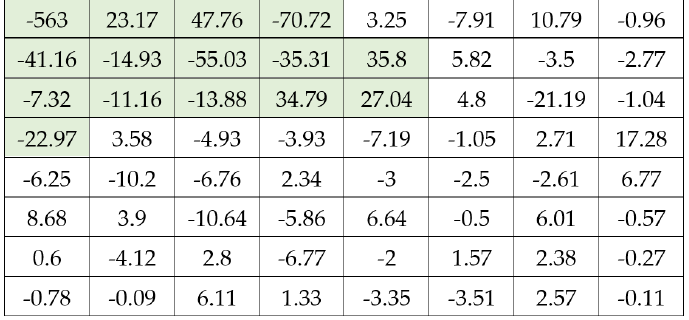
Figure 7. The DCT coefficients.